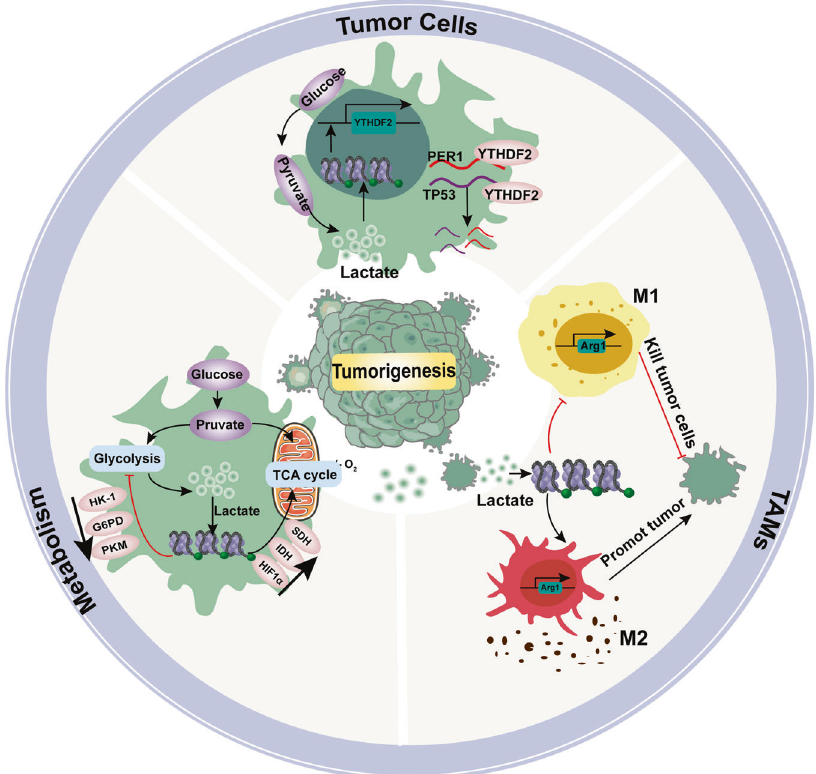
Fig. 3 Mechanism by which lactylation promotes tumorigenesis. Lactylation leads to tumor immunosuppression by maintaining TAM homeostasis. Lactylation directly promotes the expression of the oncogene YTHDF2 in tumor cells. Lactylation maintains the metabolic homeostasis of tumor cells. Lactylation may lead to tumor immunosuppression and immune escape by inhibiting the function of various immune cells in the TME. HK-1 hexokinase-1; G6PD glucose-6-phosphate dehydrogenase; PKM pyruvate kinase; SDH